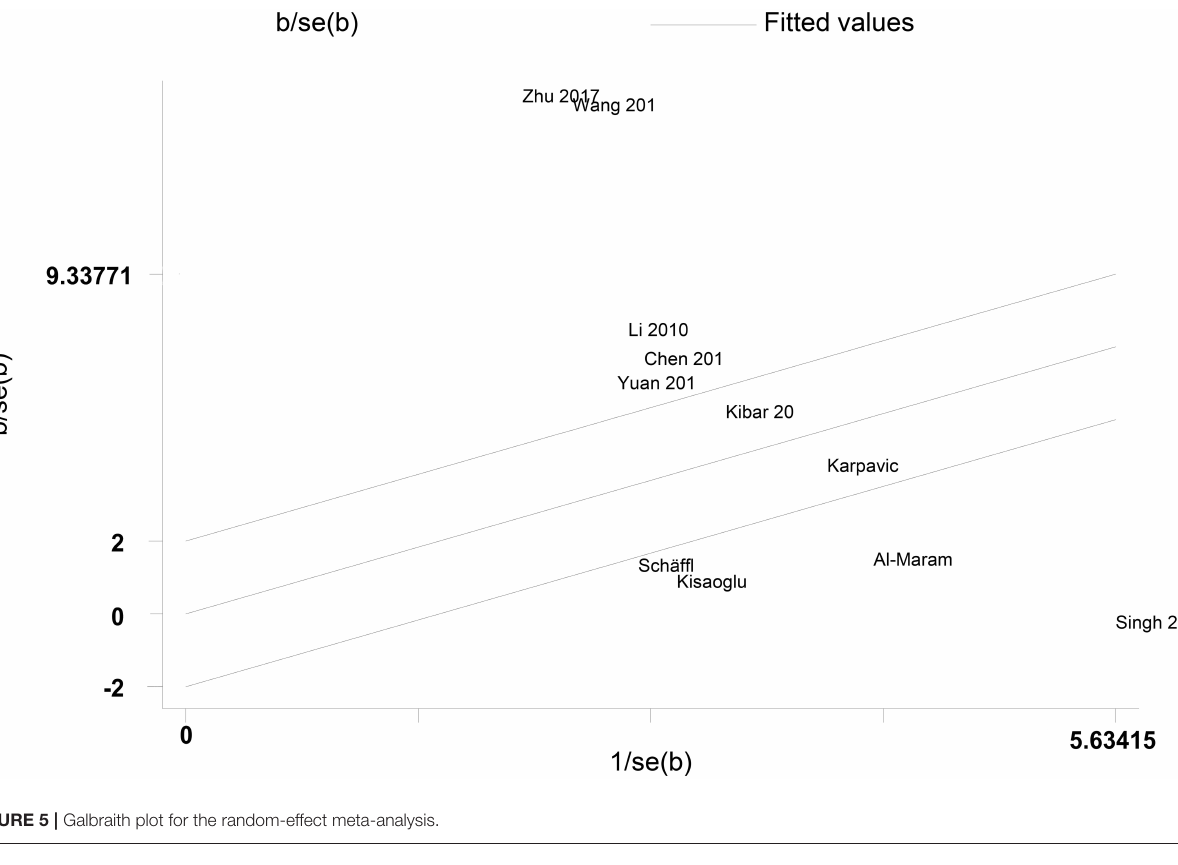
FIGURE 5 | Galbraith plot for the random-effect meta-analysis.